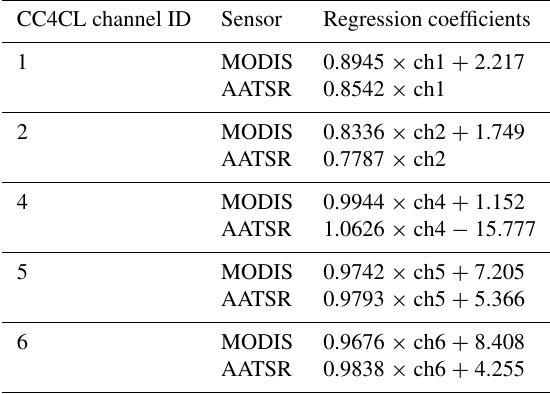
Table 4. Cloud type classification for CC4CL and CALIOP. n/a – not